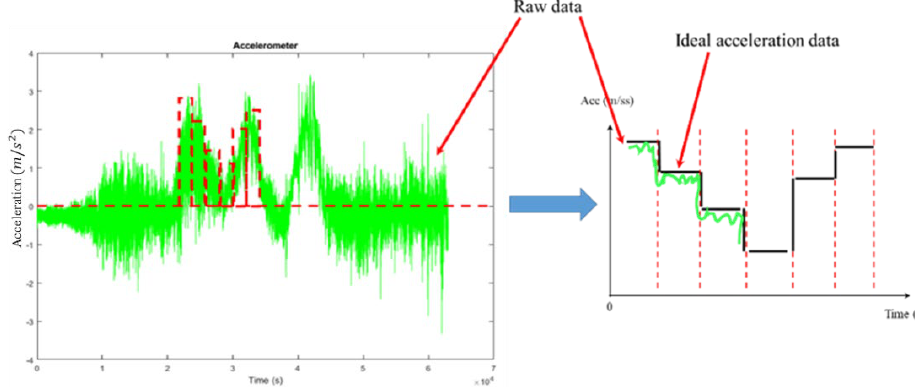
Figure 1. Time − divided IMU